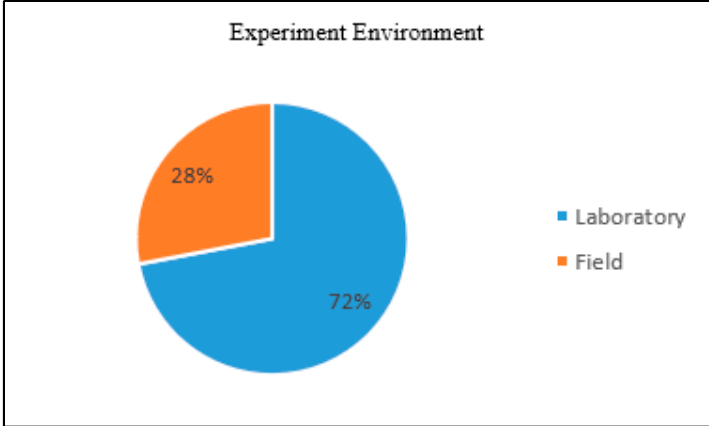
Figure 8. Experimental environments of existing applications.